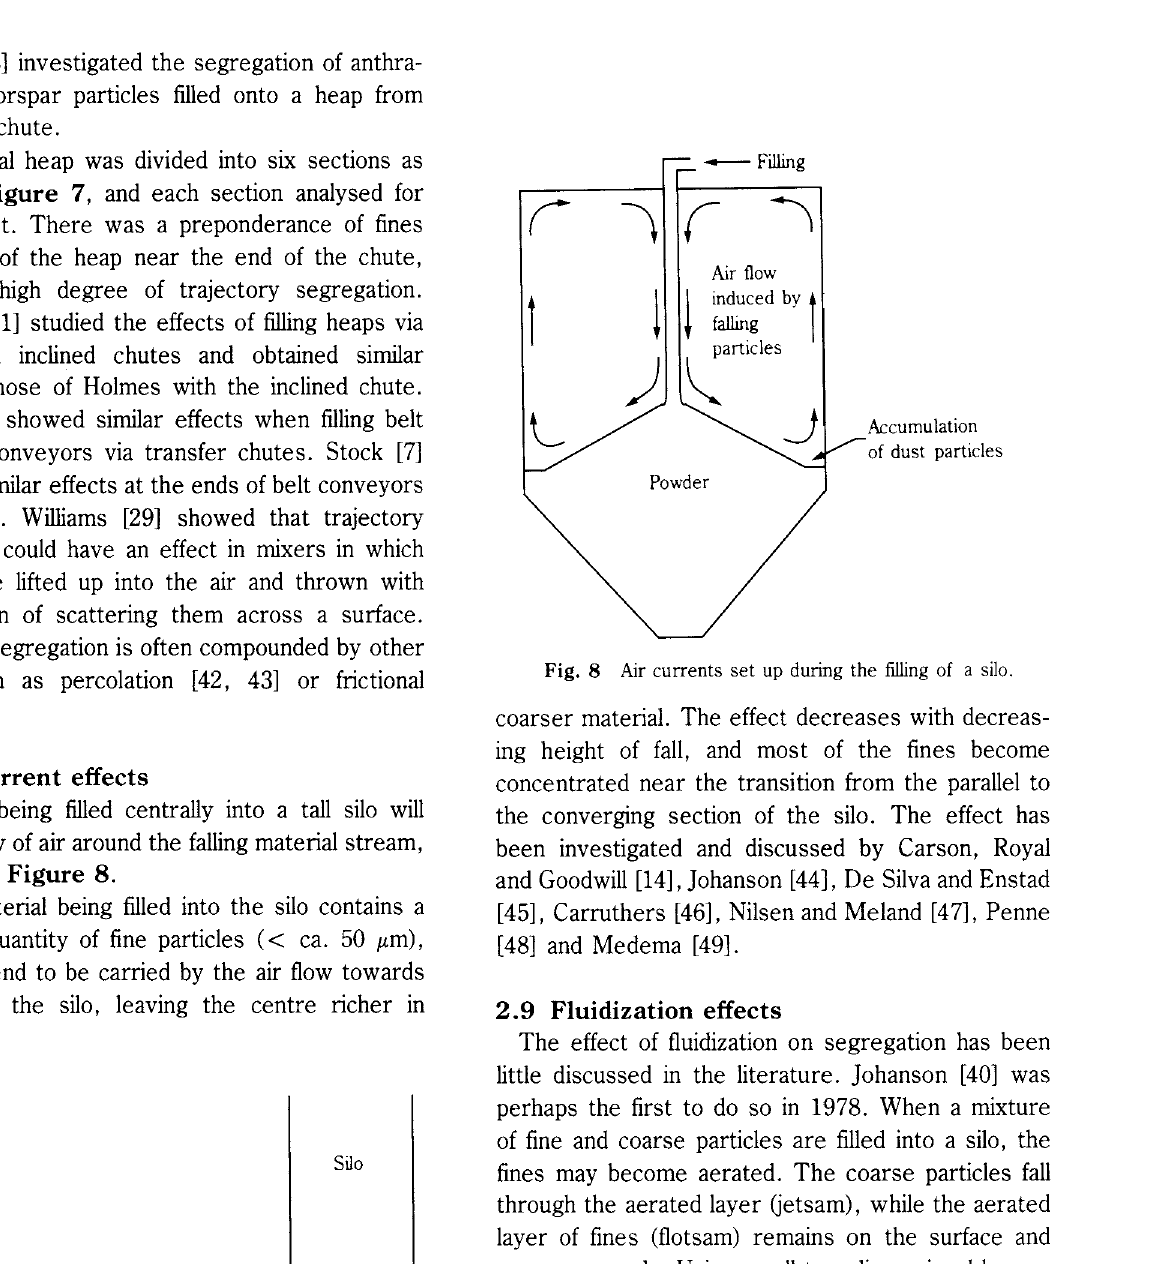
Fig. 7 Segregation in a heap as a result of trajectory segregation. Content of fines is shown in different parts of the heap.